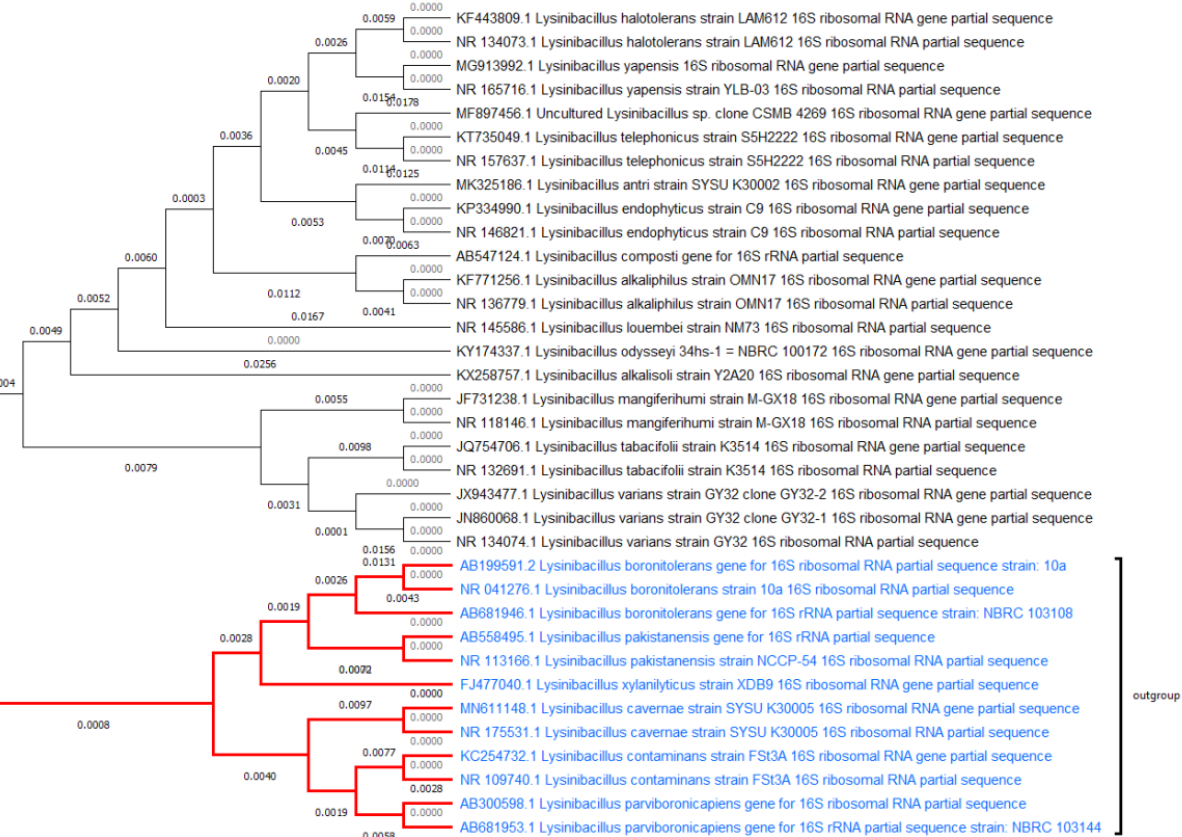
Figure 2. Phylogenic evaluation of Lysinibacillus species.